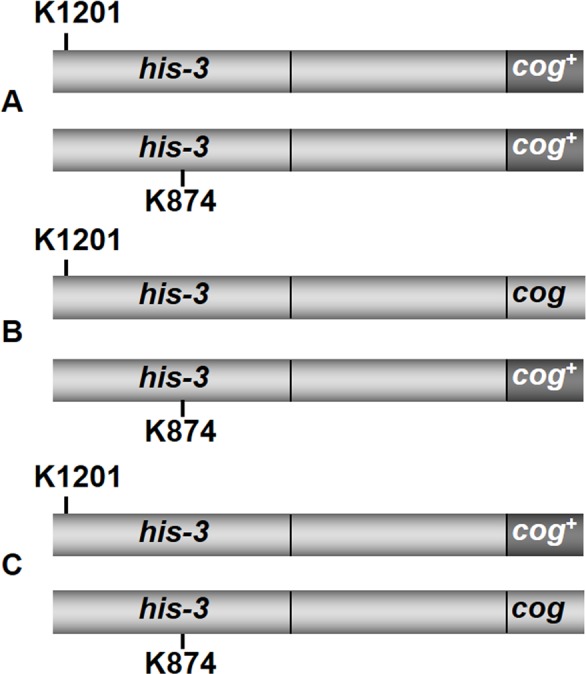
Possible arrangements of cog+, cog and alleles his-3K1201 and his-3K874.The centromere is to the left of the figure and ad-3 is to the right. The figure is not to scale. In A, the cross is homozygous for cog+; in B, cog+ is cis to his-3K874, the mutant site closer to cog; while in C, cog+ is cis to his-3K1201, the mutant site further from cog.